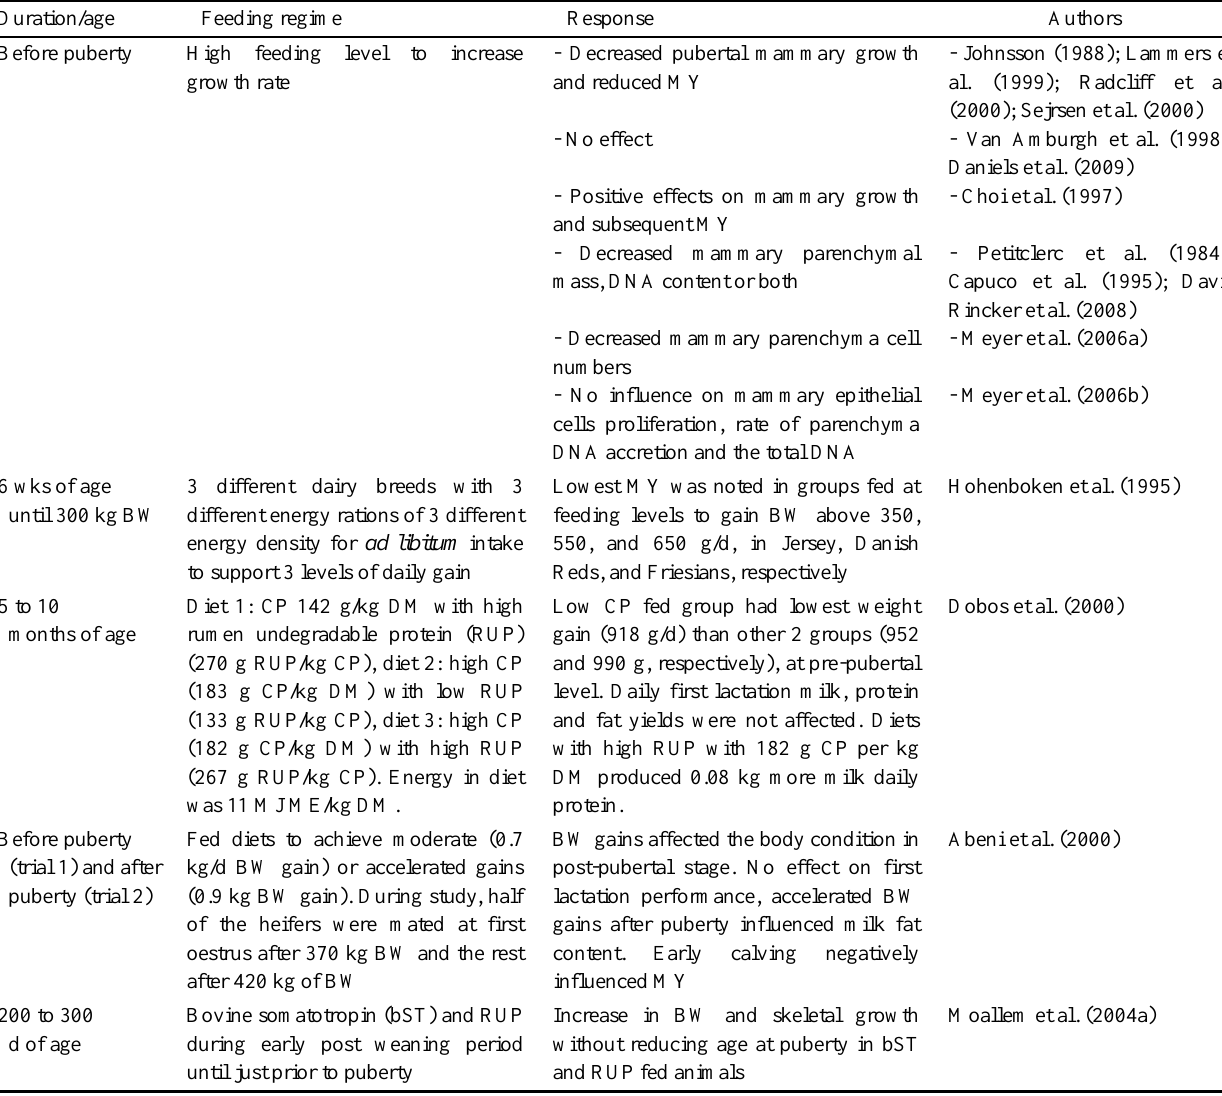
Table 2. Effect of pre-pubertal feeding on heifer performance, mammary gland and milk yield (MY)